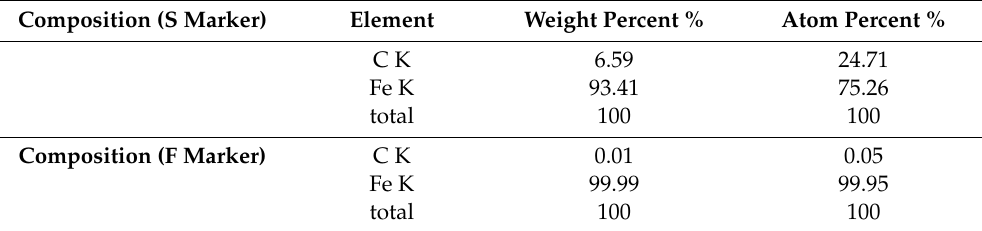
Figure 4. Microstructures of the ( a ) MCMB–Fe composite and the ( b ) GrF–Fe composite. Table 3. Chemical compositions of the different points.